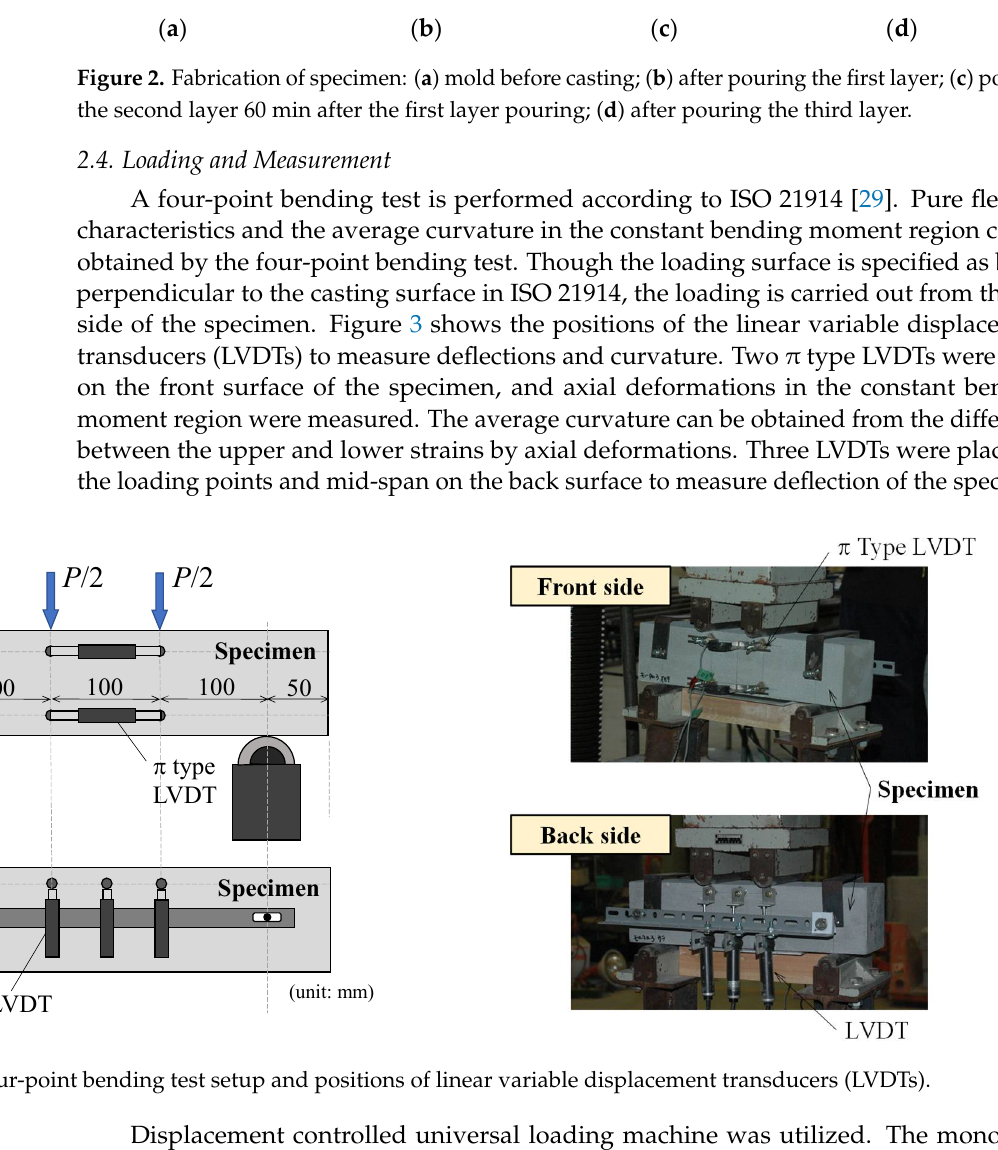
Figure 2. Fabrication of specimen: ( a ) mold before casting; ( b ) after pouring the first layer; ( c ) pouring the second layer 60 min after the first layer pouring; ( d ) after pouring the third layer.